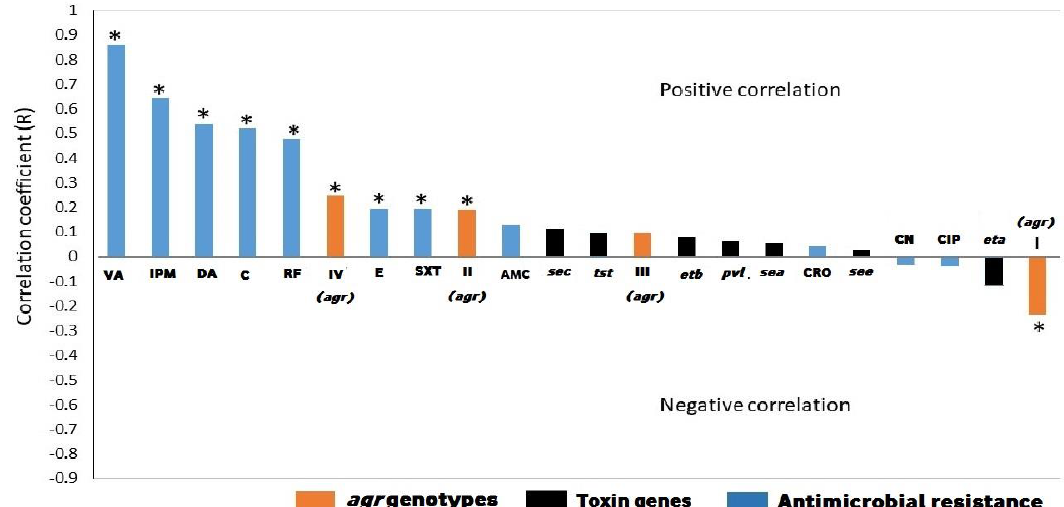
Figure 2. Correlation between biofilm production and antimicrobial resistance, toxin genes, and agr genotypes of methicillin-resistant Staphylococcus aureus isolates. VA: vancomycin; IPM: imipenem; DA: clindamycin; C: chloramphenicol; RF: rifamycin SV; E: erythromycin; SXT: trimethoprim- sulfamethoxazole; AMC: amoxicillin-clavulanic acid; CRO: ceftriaxone; CN: gentamicin;